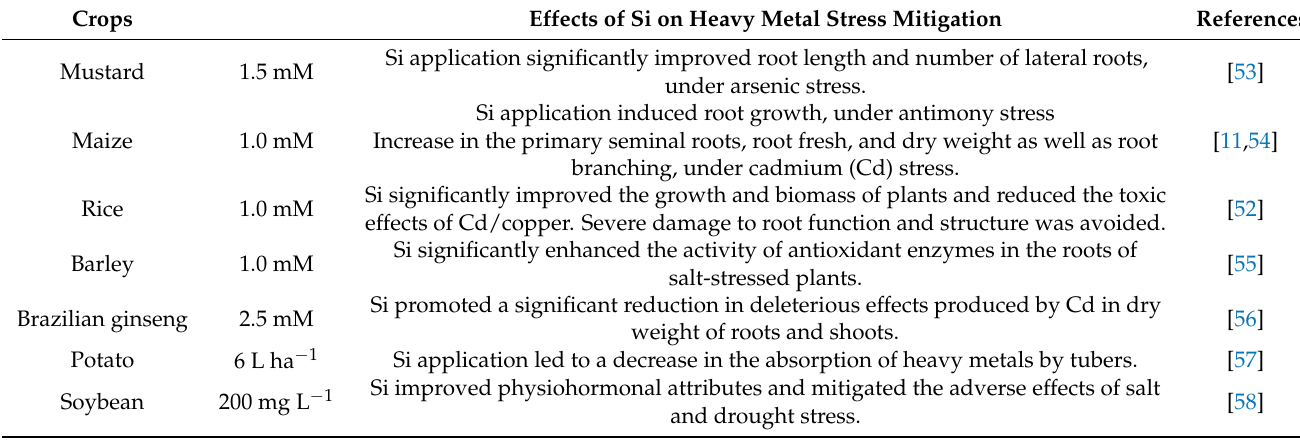
Table 2. Effects of Si application on heavy metal translocation in various crops. Crops Effects of Si on Heavy Metal Stress